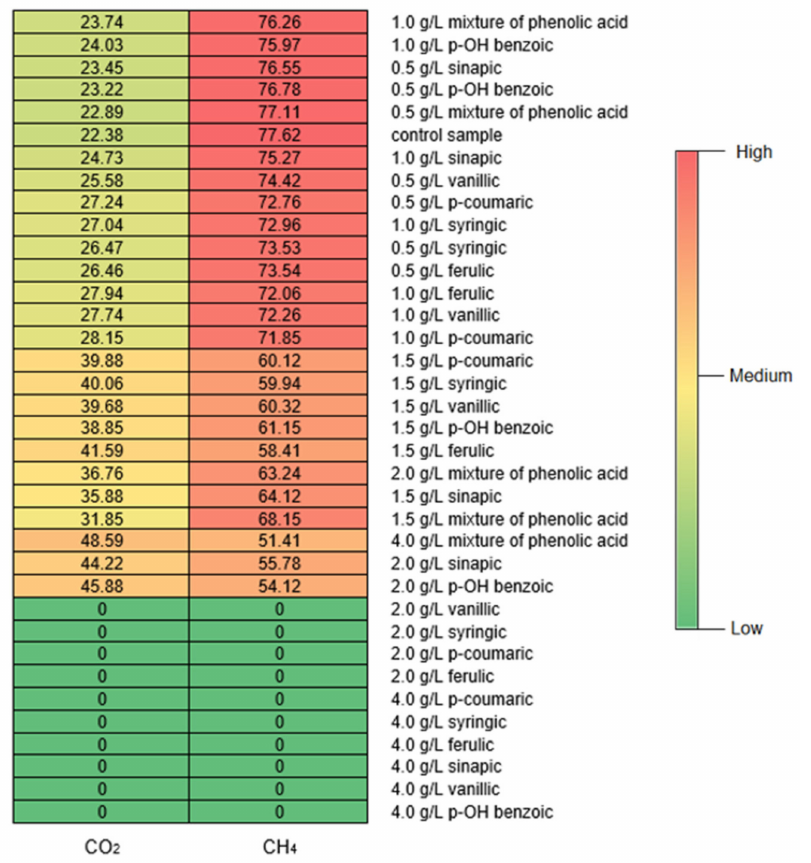
Figure 2. Percentage of methane and carbon dioxide in the biogas. Grouping was based on hierar- chical agglomerative clustering. The percentage of methane and carbon dioxide is represented by a color (light blue means lower value; dark blue means higher value). The color key is indicated in the legend in the top left of the plot, along with the count of the same case in each